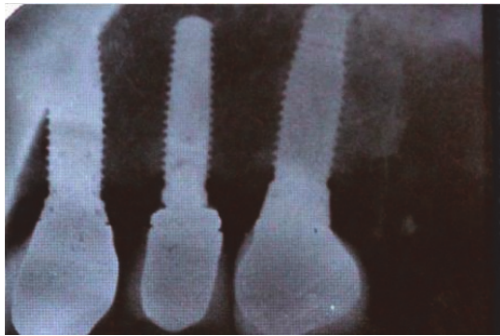
Figure 9: Intraoral radiograph at the 1-year